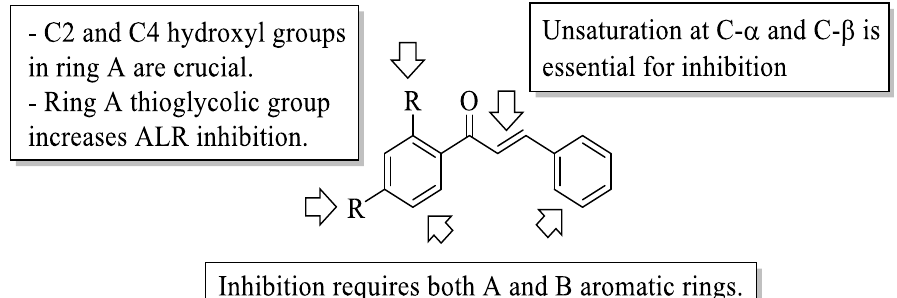
Figure 24. SARs of chalcones for ALR inhibition activity